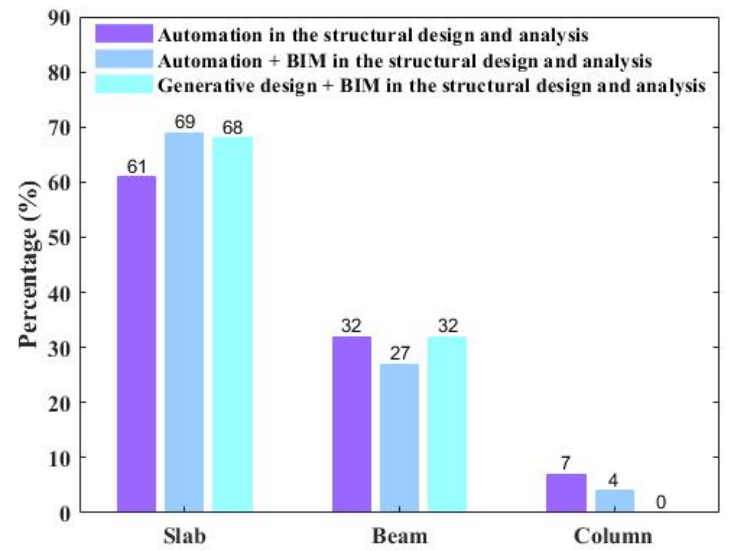
Figure 19. Percentage of automated structural design achieved. Figure 16. Percentage of automated structural design achieved.